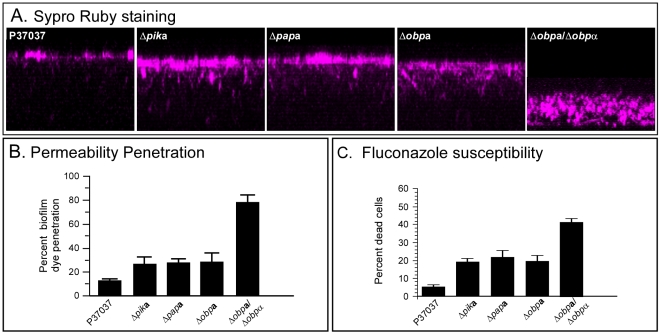
The biofilms formed by the mutants Δpika, Δpapa and Δobpa show small increases in SYPRO Ruby permeability and fluconazole susceptibility, but the biofilms formed by the mutant Δobpa/Δobpα show larger increases in SYPRO Ruby permeability and fluconazole susceptibility.A. SYPRO Ruby penetration. B. Quantitation of SYPRO Ruby penetration. C. Fluconazole susceptibility.